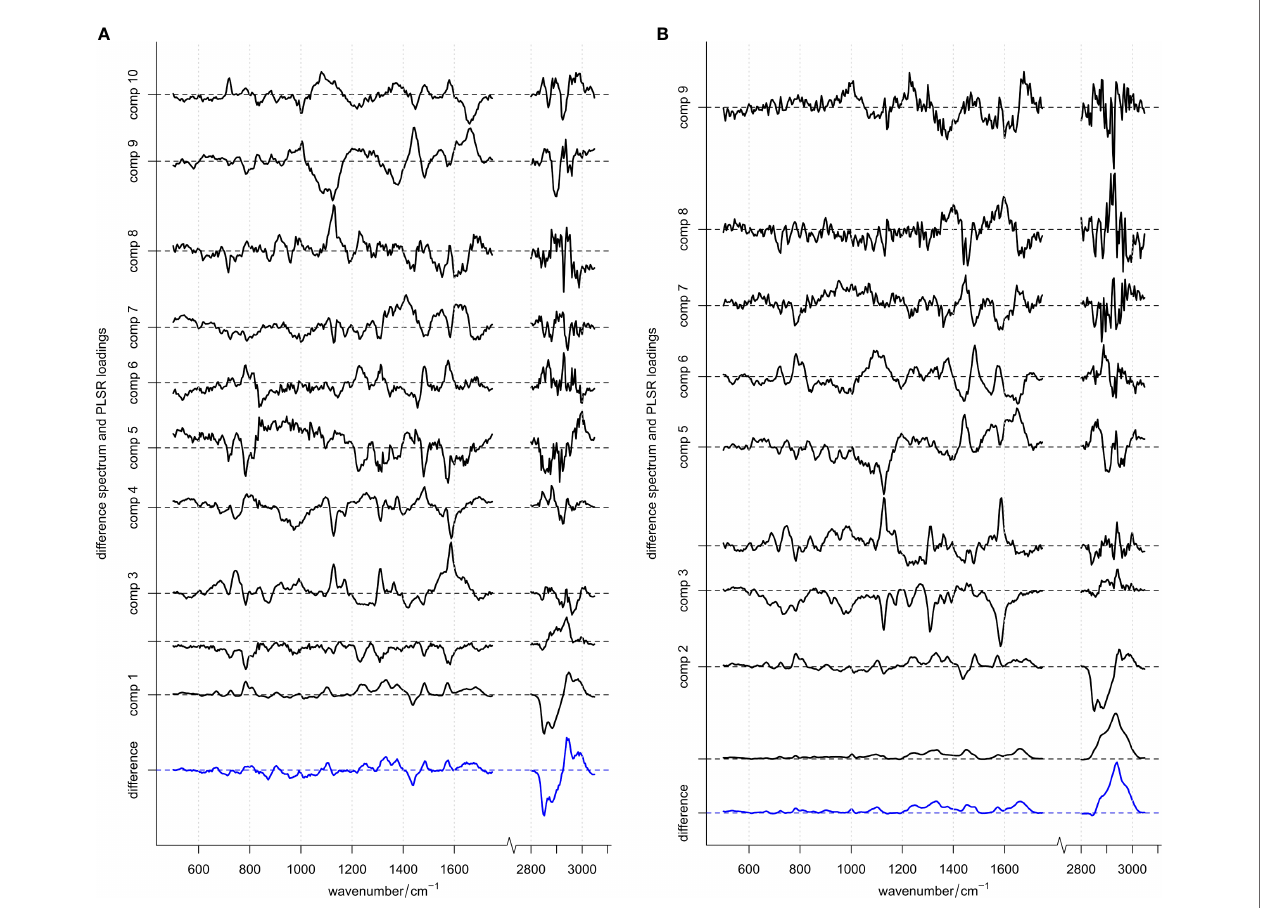
FIGURE 2 | Difference spectrum (blue, bottom) and PLSR loadings (black) for models. (A) With and (B) without vector normalization applied to the spectral data in the training set. Difference spectra (computed by subtracting the mean spectrum of S. pneumoniae from the mean spectrum of other streptococci) are scaled appropriately matching the loadings scale and are depicted in blue. Loadings are shown in black with increasing components organized from bottom to top. For each spectrum the “ zero line ” on the y-axis (contribution of Raman intensity) is indicated with a dotted line. ROC curve using these 10 or 9 loadings, respectively, are depicted in Supplementary Figure S4